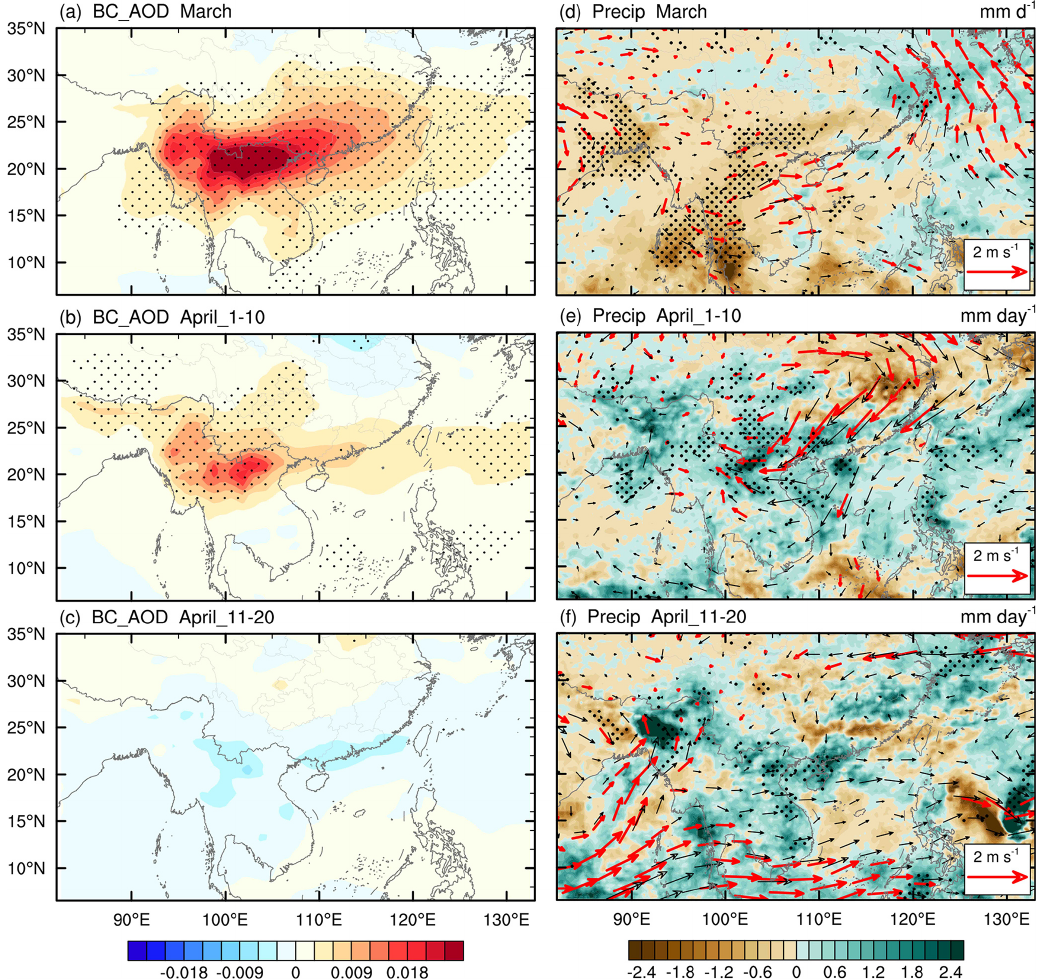
Figure 3. Regressions of anomalies in (a–c) BC AOD (shading; unitless) and in (d–f) precipitation (shading; mmd − 1 ) and 850hPa wind (vector; ms − 1 ) onto the standardized BBAI in (a, d) March, (b, e) early April, and (c, f) mid April. Stippling (red vector) denotes that the regressed anomalies of BC AOD and precipitation (of wind) are statistically significant at the 95% confidence level based on a Student’s t